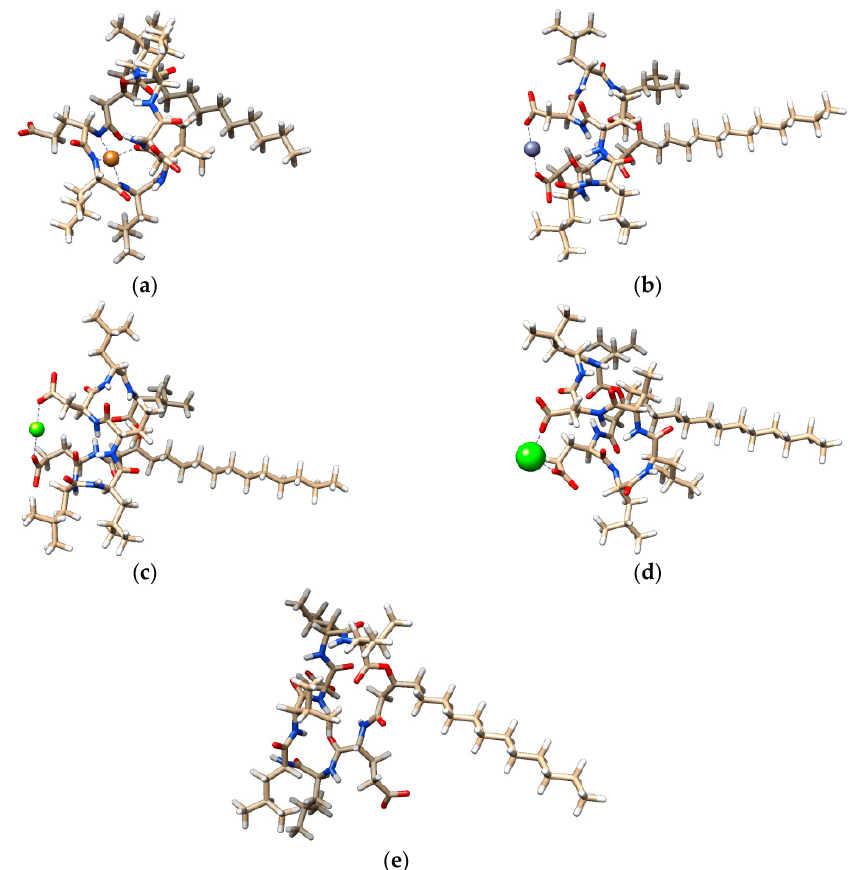
Figure 2. Predicted orientations of the lowest energy conformations of surfactin-C 15 and its complexes with divalent metal ions: Cu 2+ -surfactin ( a ), Zn 2+ -surfactin ( b ), Mg 2+ -surfactin ( c ), Ca 2+ -surfactin ( d ) and surfactin ( e ).